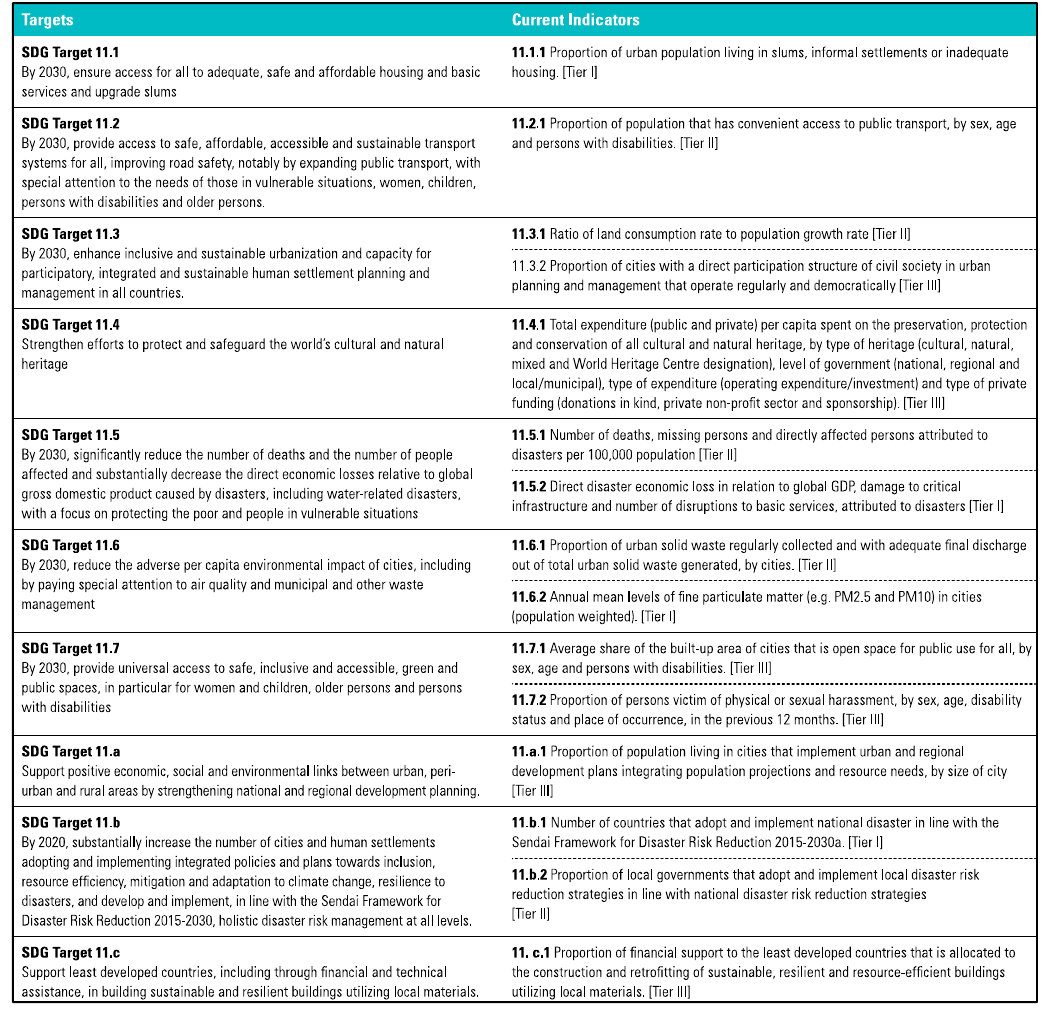
Figure A1. SDG 11 targets and indicators [42] (p.9).